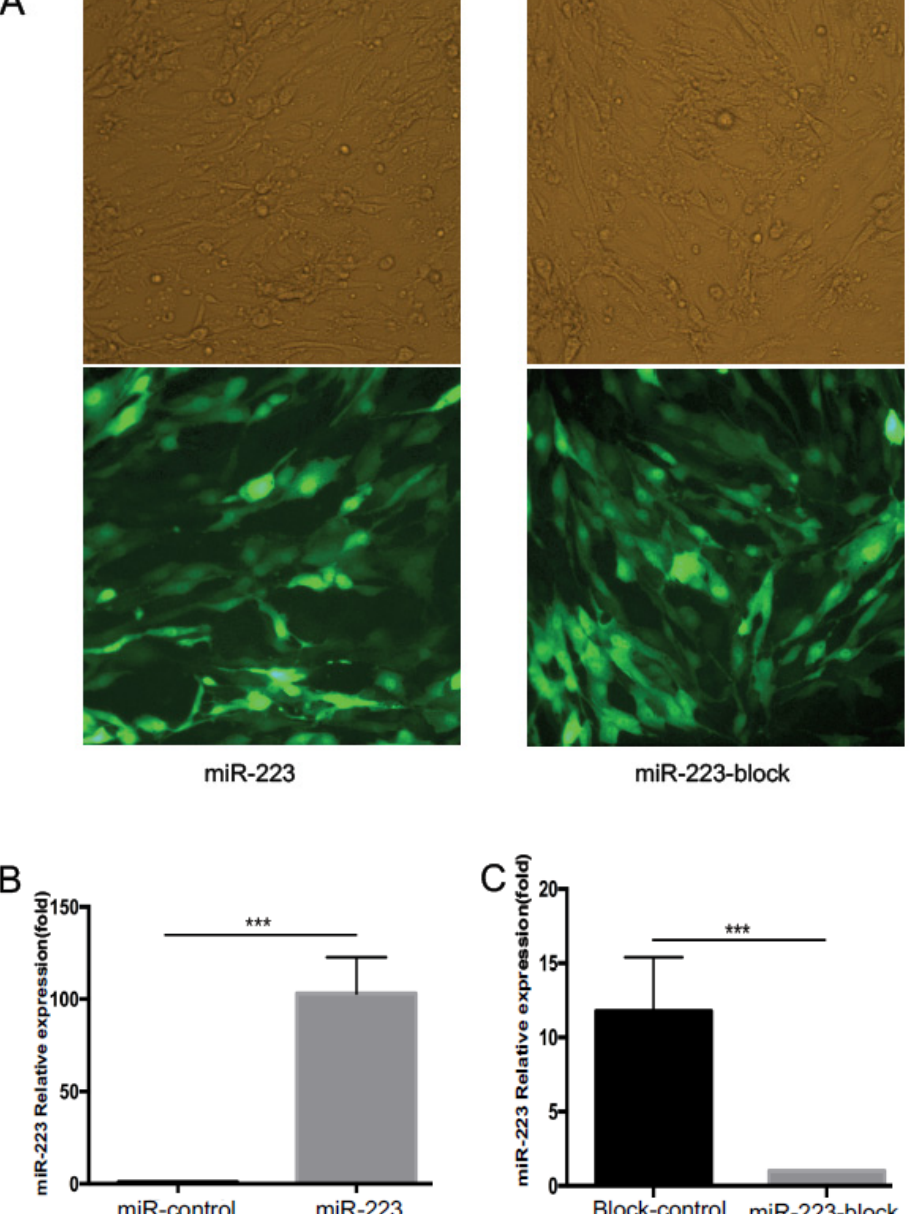
Figure 2. Transfection efficiency and miR-223 expression after transfected with miR-223 and miR-223-block lentivirus. ( A ) Fluorescent cells that transfected with miR-223 and miR-223-block lentivirus. Note that almost all cells were successfully transfected. Scale bar = 30 µ m. Bar graph showing a quantification analysis of miR-223 level in miR-223 ( B ) and miR-223-block ( C ) group, which suggested that the expression of miR-223 was significantly altered after transfection with target lentivirus n = 8 per group; data are presented as mean ± SD; *** p < 0.001. miR-223: microRNA-223; SI: stretch injury.